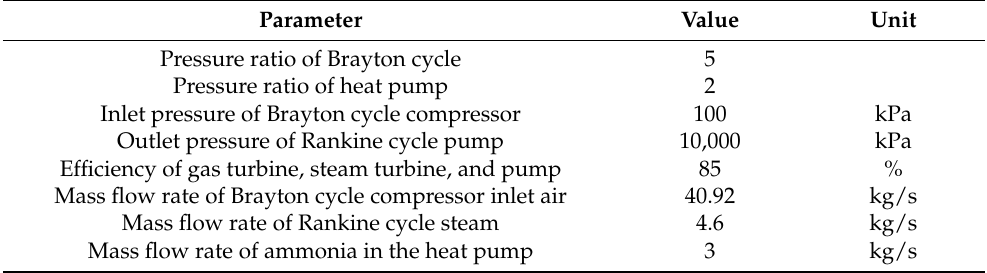
Table 2. Input variables used in the simulation.